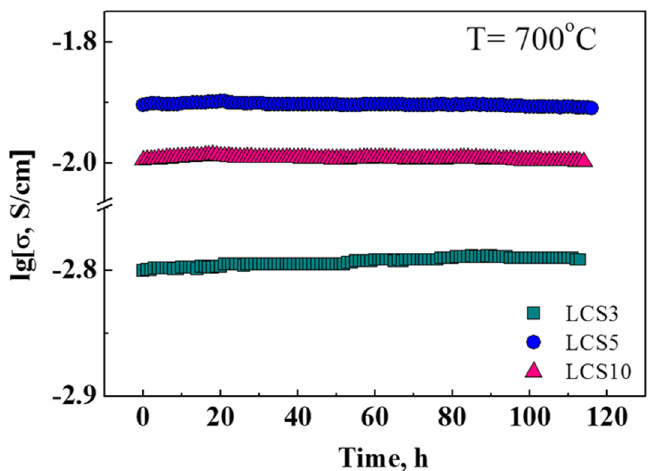
Figure 10. Evolution of electrical conductivity at 700 °C for 120 h in an oxidizing atmosphere ( p H 2 O = 4.5 kPa).